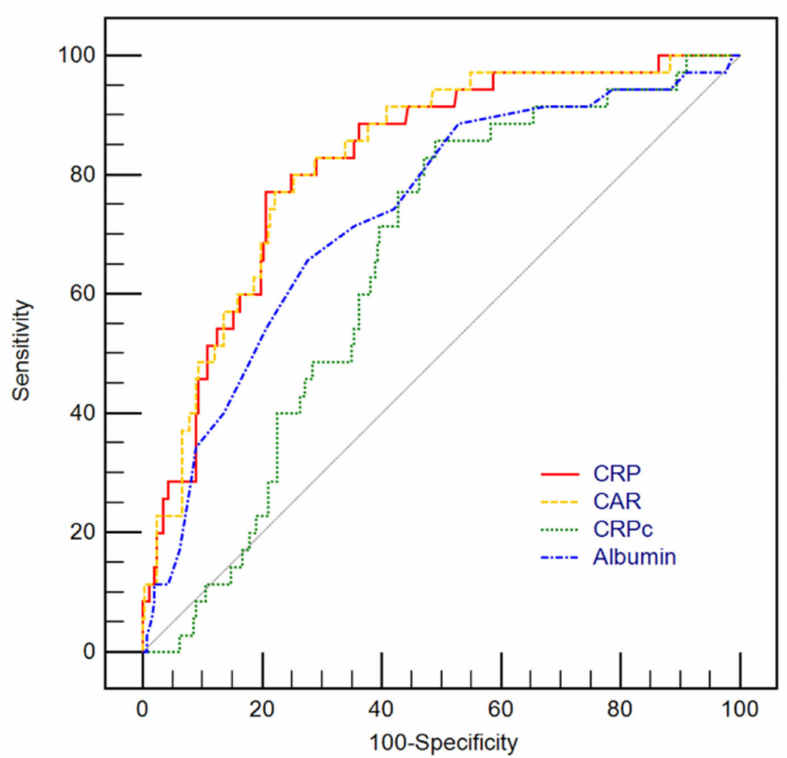
Figure 2. Receiver operating characteristic curves for predicting in-hospital mortality using levels of C-reactive protein (CRP), CRP to albumin ratio (CAR), CRP clearance (CRPc) along with albumin. The area under the curves (AUCs) of CRP (C-statistic: 0.820, 95% confidence interval [CI]: 0.772–0.863) and CAR (C-statistic: 0.824, 95% CI: 0.776–0.866) were greater than that of CRPc (C-statistic: 0.650, 95% CI: 0.592–0.704) and Albumin (C-statistic: 0.734, 95% CI: 0.679–0.784) with significant statistical differences (all p < 0.05). However, there were no statistically significant differences between AUC of CAR and CRP ( p =